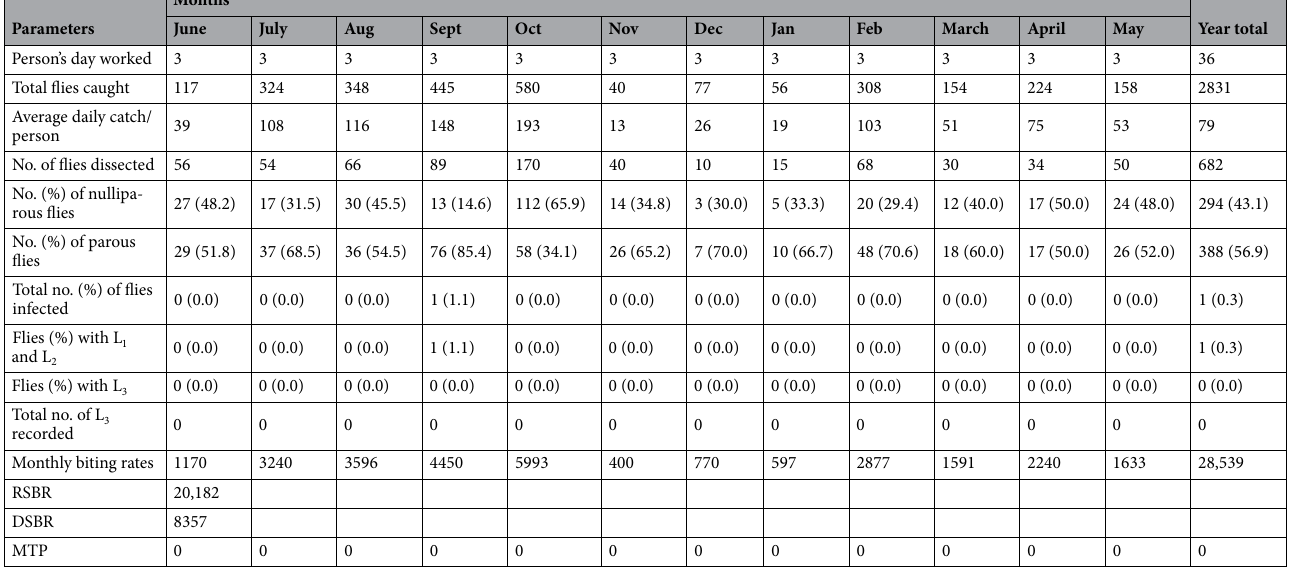
Table 1. Population density and transmission indices of S. damnosum at Agbokim waterfall. [RSBR = Rainy season biting rate (May–October), DSBR = Dry season biting rate